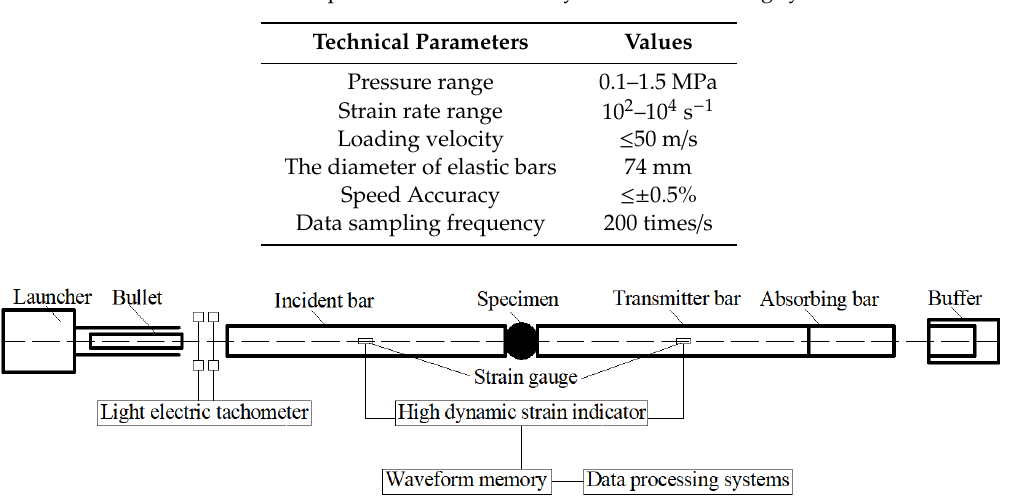
Table 5. Technical parameters and accuracy of the SHPB testing system.